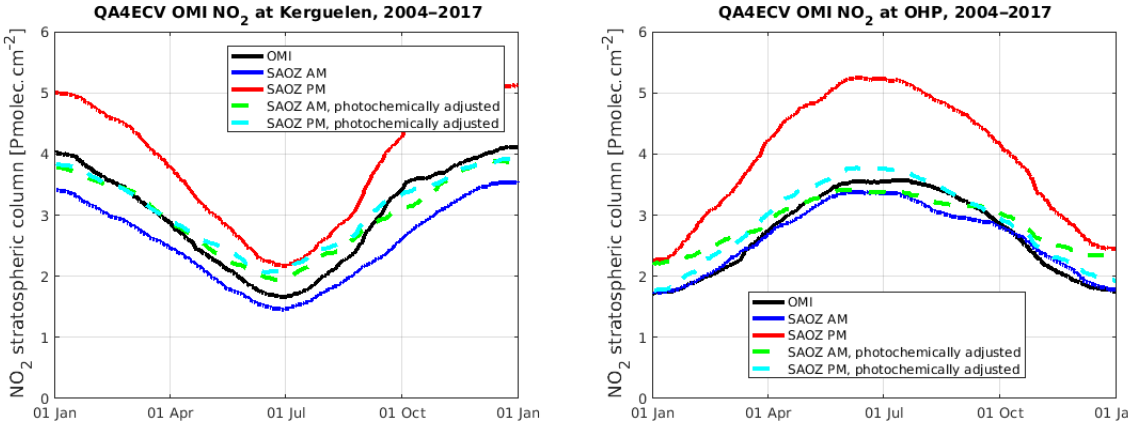
Figure 5. Climatological, i.e. all years mapped to a single year and with a 1-month smoothing function applied, comparison between QA4ECV OMI stratospheric NO 2 and the ZSL-DAOS instruments at Kerguelen and the Observatoire de Haute-Provence (OHP), revealing overall good agreement.